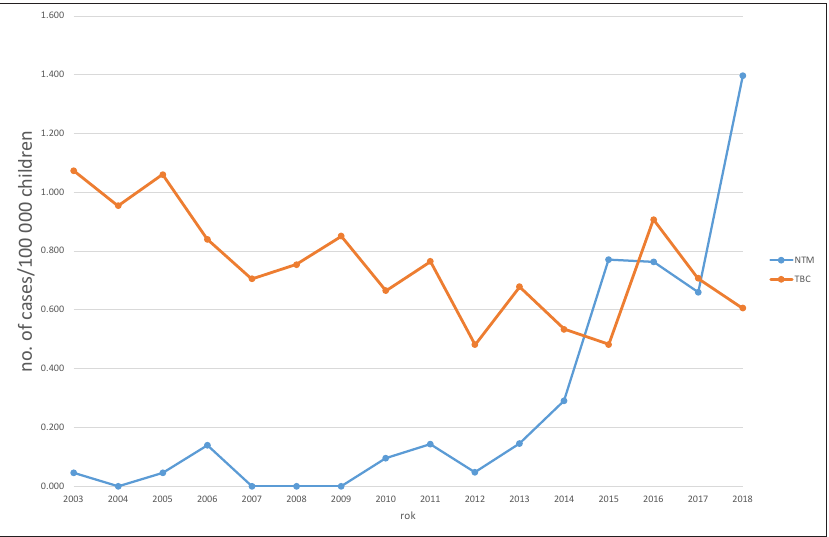
Fig. 3. Incidence of NTM and TB in the Czech Republic in the period